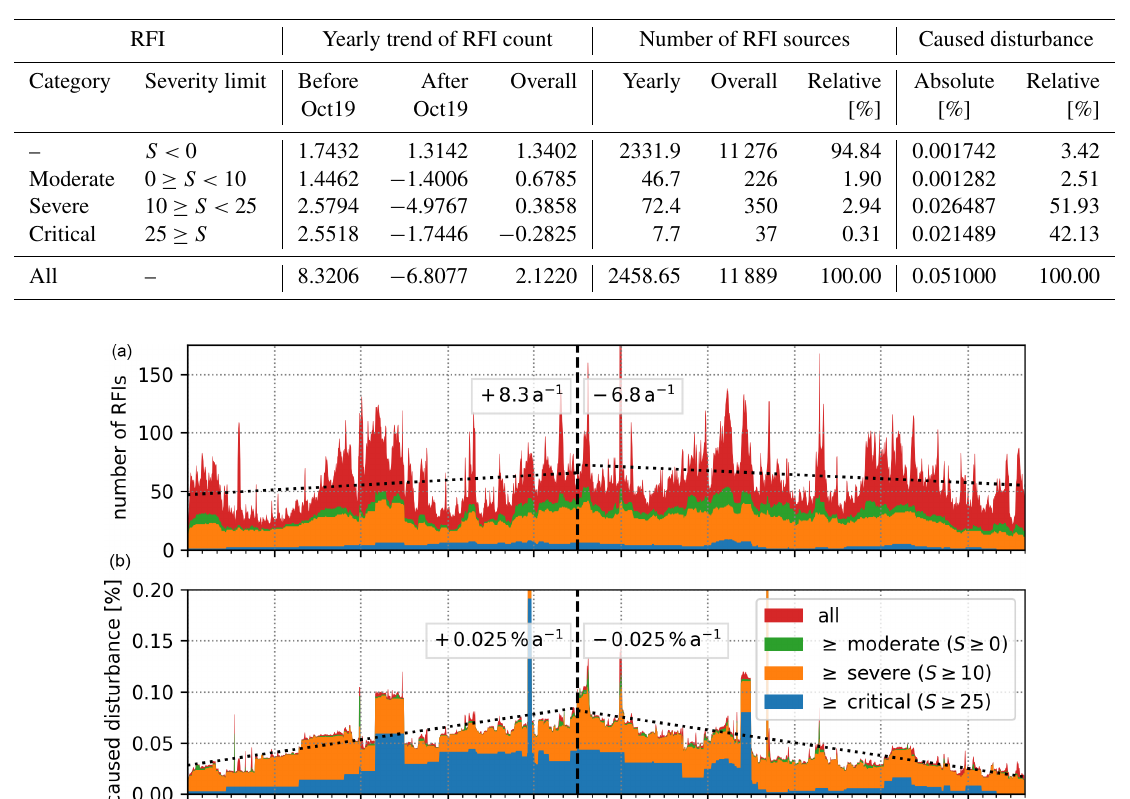
Table 2. Historical trends and statistics of detected RFI sources by RFI category including data from July 2017 until May 2022 are given. The trends are also provided relative to the implementation date of the first automatic RFI detection in October 2019 (referenced as Oct19) The caused disturbance is given relative to the total amount of possible rays (288 rays in one direction during a day at each elevation for each site).